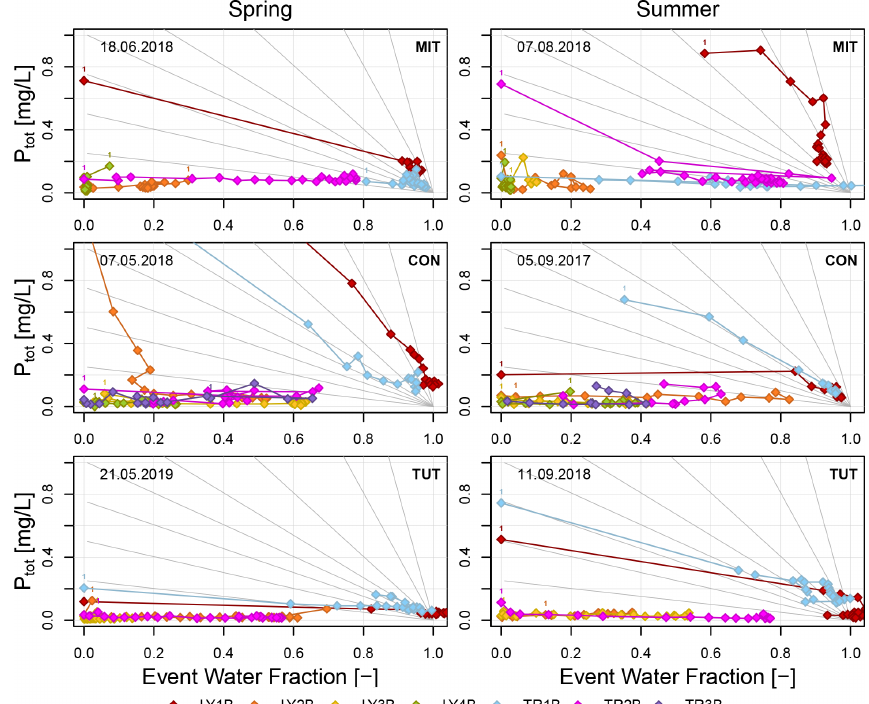
Figure 7. P tot concentrations as a function of the event water fraction calculated for the sprinkling experiments. Gray lines indicate a selection of possible lines that describe the theoretical change in P tot concentration assuming simple dilution (i.e., proportional mixing of event and pre-event water according to the event water fraction). Label “1” indicates the first data point of each flow